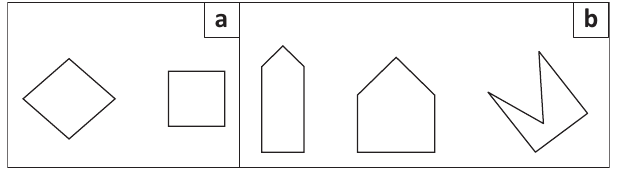
FIGURE 7: Different orientations of a square and a pentagon.